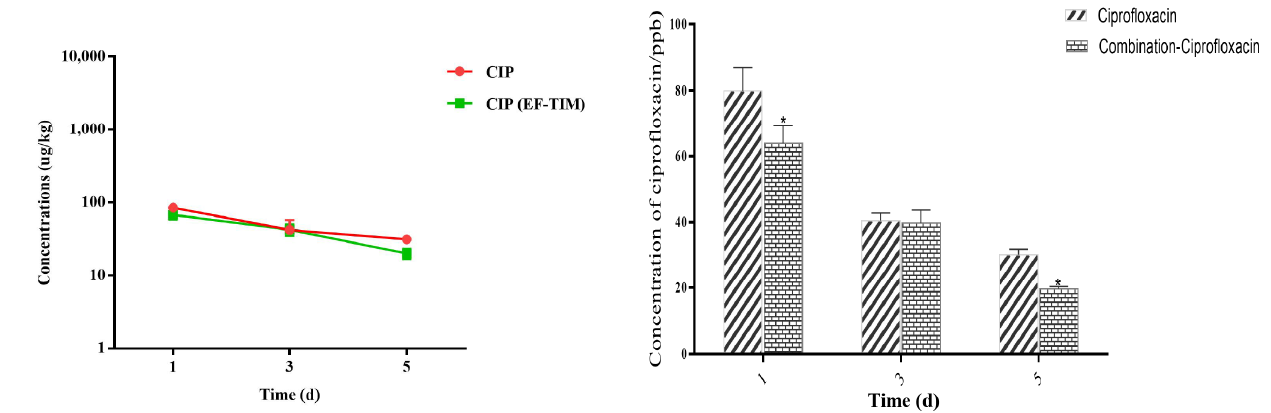
Figure 2. Time-lapse graphs of EF in eggs. Note: EF (enrofloxacin), TIM (tilmicosin). The data were expressed as mean ± SD. * p < 0.05 denoted statistical significance.